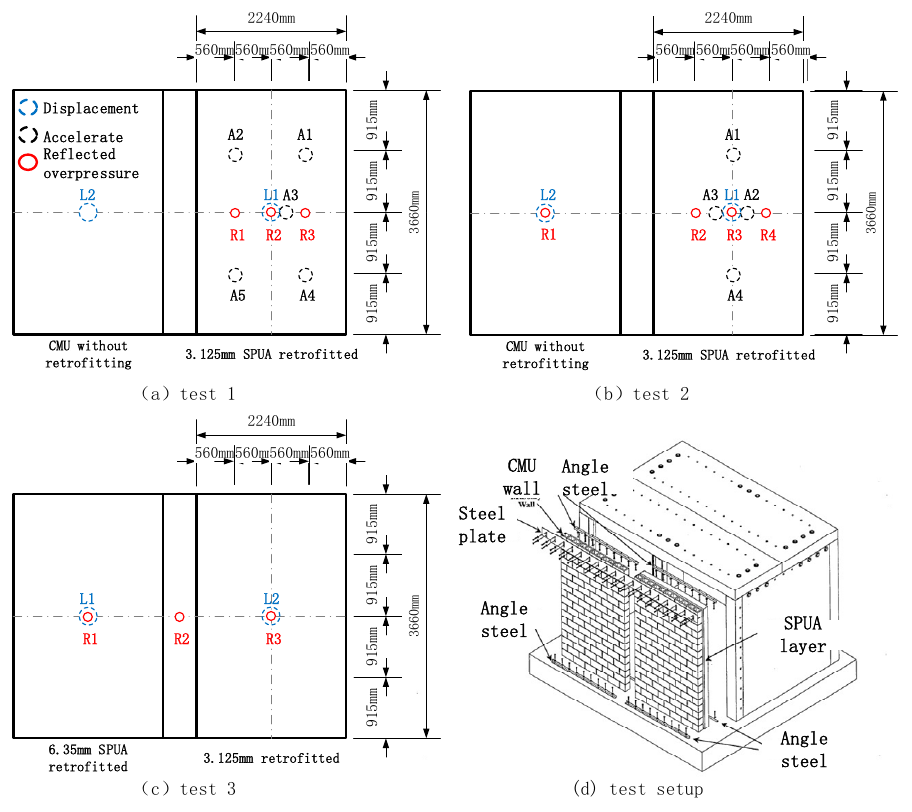
5 of 18 Table 1. Main test data.